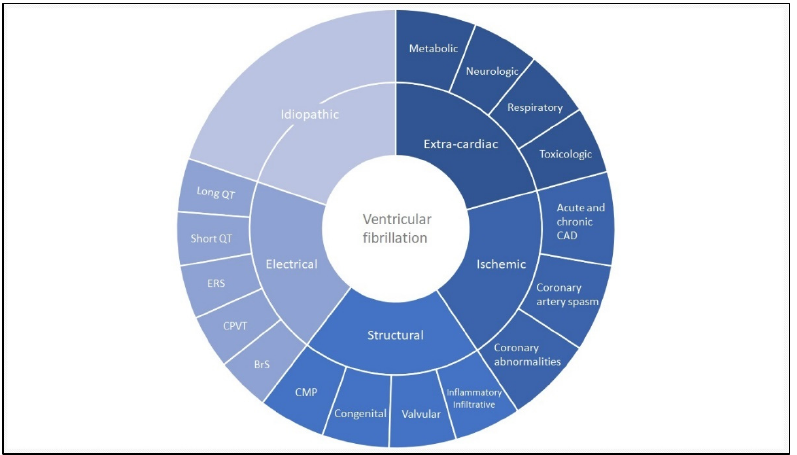
Figure 1. Ventricular fibrillation: disease overview. Most common causes of ventricular fibrillation stratified between extra-cardiac, ischemic, structural, electrical and (after exclusion) idiopathic ven- tricular fibrillation. The figure does not represent percentages. Cardiomyopathies most commonly include arrhythmogenic cardiomyopathy, dilated cardiomyopathy and hypertrophic cardiomyopa- thy. Inflammatory or infiltrative diseases include myocarditis, sarcoidosis and amyloidosis. Coro- nary abnormalities include coronary anomalies and myocardial bridging. BrS: Brugada syndrome; CAD: coronary artery disease; CMP: cardiomyopathy; CPVT: catecholaminergic polymorphic ven- tricular tachycardia; ERS: early repolarization syndrome; VF: ventricular fibrillation.